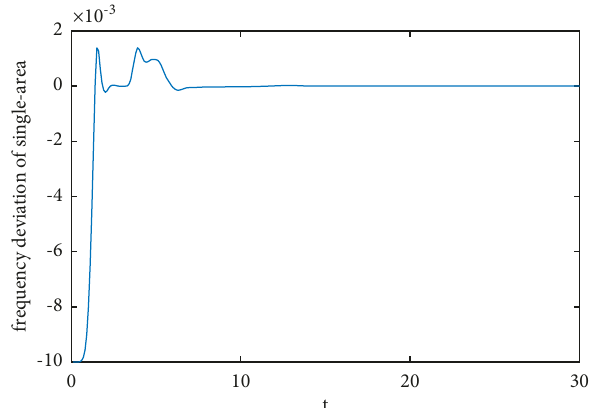
Figure 9: Frequency responses with h � 6 . 64 ( μ � 0 . 9 ) of single-area.